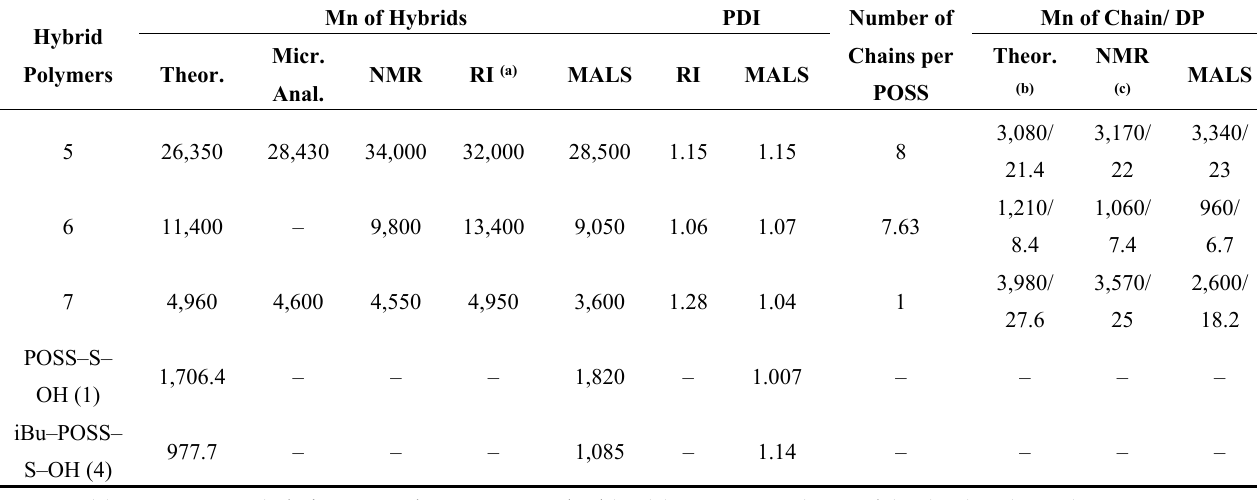
Table 3. Polymers of L,L -dilactide initiated from POSS